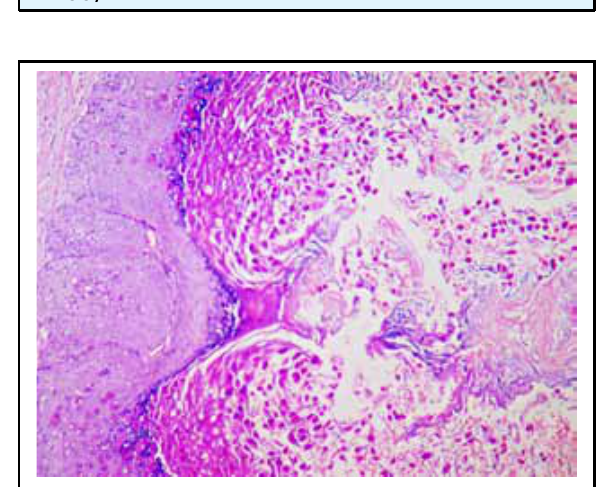
Figure 2(c). Large cytoplasmic inclusions in keratino - cytes with peripheralized shrunken nuclei (H and E, ×400).